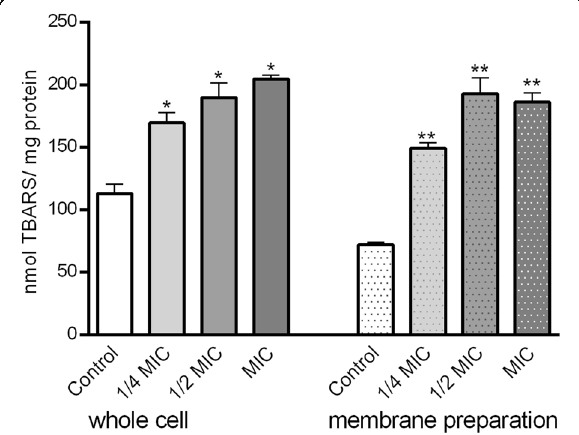
Fig. 7 Lipid peroxidation levels in control and berberine-treated cells of C. albicans and their isolated membranes. Berberine induced dose-dependent increase in TBARS /MDA level as a measure of lipid peroxidation. Cells were treated with berberine (1/4×MIC, ½×MIC and 1×MIC) and the level of lipid peroxidation was assessed in complete cells and membrane preparations. MDA concentration was determined using the TBARS assay. The data are presented as mean values ± SD (*p < 0.01; **p < 0.05; ***p < 0.001).